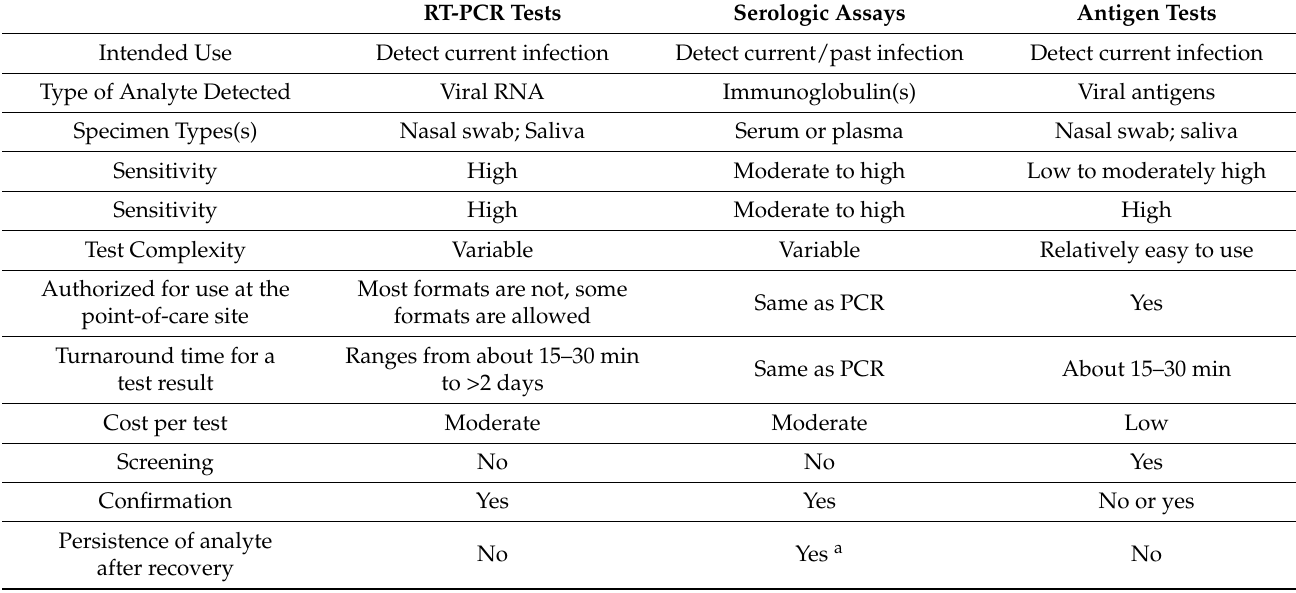
Table 1. Summary of some of the similarities and differences between molecular-based tests (for example, RT-PCR), serologic assays and antigen-detection tests that are currently in use for the diagnosis of